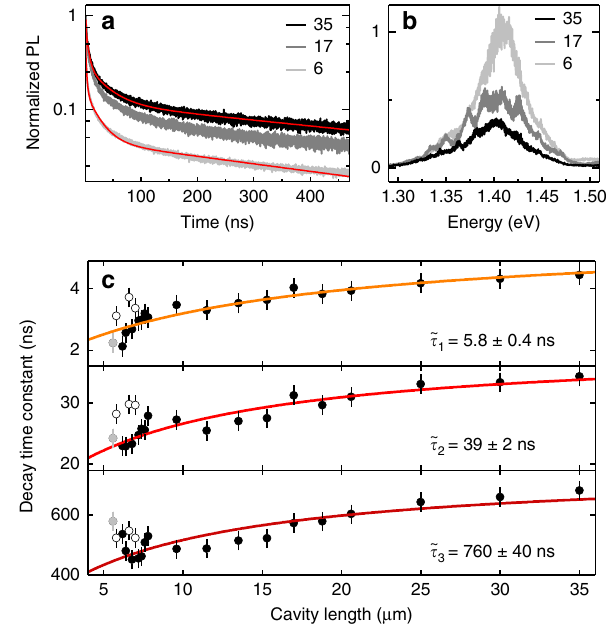
Fig. 4 a Traces of interlayer exciton PL decay shown for three selected cavity lengths of 35, 17, and 6 μ m. The solid lines are fi ts to the data with three-exponential decay constants. Note the speed up in the decay upon the reduction of the cavity length. b Spectra of interlayer exciton PL for the corresponding cavity lengths. c The evolution of the characteristic decay constants with the cavity length is shown by closed circles (error bars: least squares from best fi t with three-exponential decay channels). The solid lines show model fi ts according to the theory of generalized Purcell enhancement. Open circles represent data where the cavity mode was spectrally detuned from the resonance with the interlayer peak; data shown in light gray were discarded from the fi t procedure due to presumable physical contact between the fi ber and the